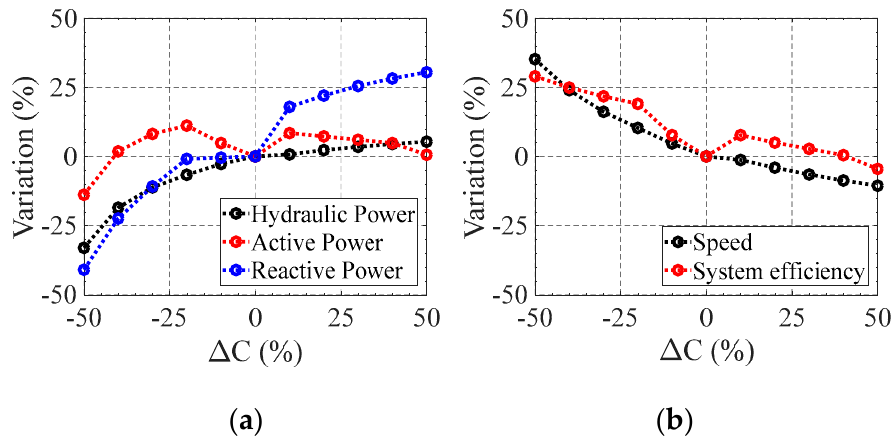
Figure 18. Variation of hydraulic and electromechanical quantities after a change in the capacitor, C: ( a ) variation of hydraulic (black), active (red) and reactive (blue) powers, and ( b ) variation of speed (black) and system (red) efficiency.